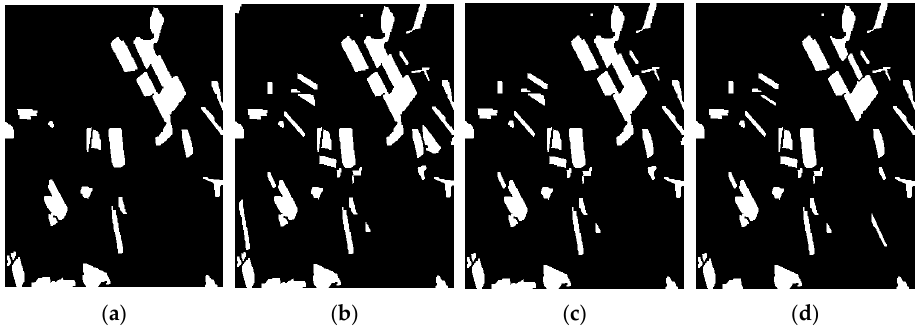
Figure 4. Object-based CD results based on segmentation maps obtained by a value of Q of ( a ) 32; ( b ) 64; ( c ) 128; ( d ) 256. Table 1. Accuracy of object-based CD results produced from different segmentation maps. Missed Detections False Alarms Total Q